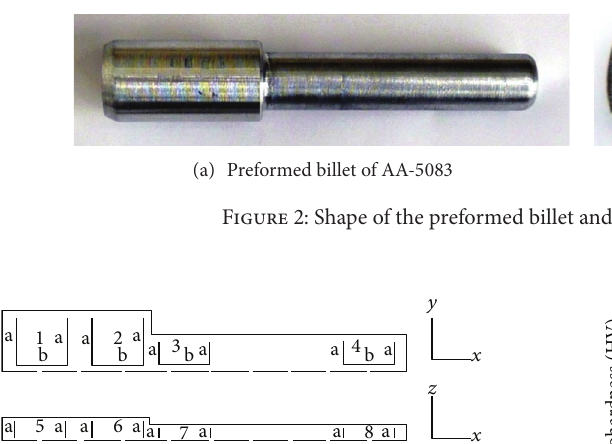
Figure 3: Blade zones (1 to 8) where the microhardness measure- ment (HV) was taken.